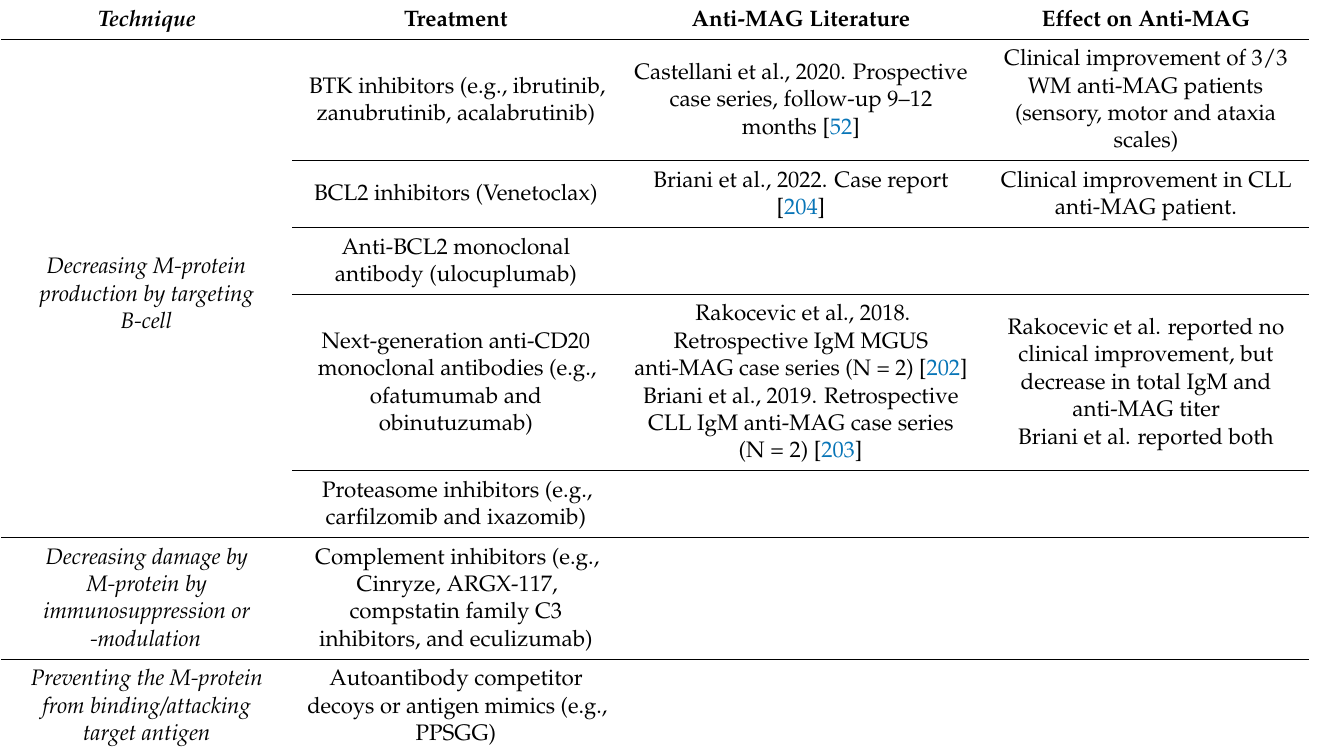
Table 3. Novel treatment options for IgM anti-MAG